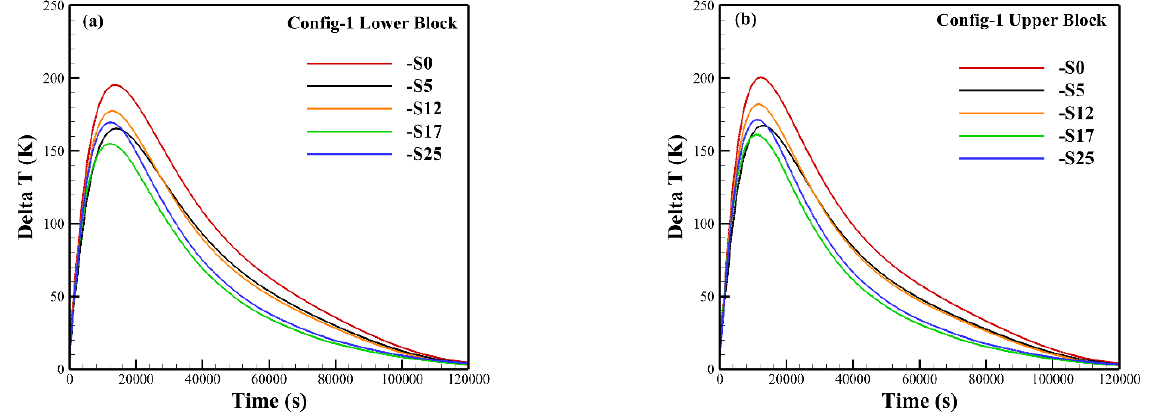
Figure 9. Effect of spacer size on temperature non-uniformities of products in Config-1: ( a ) lower block and ( b ) upper block.